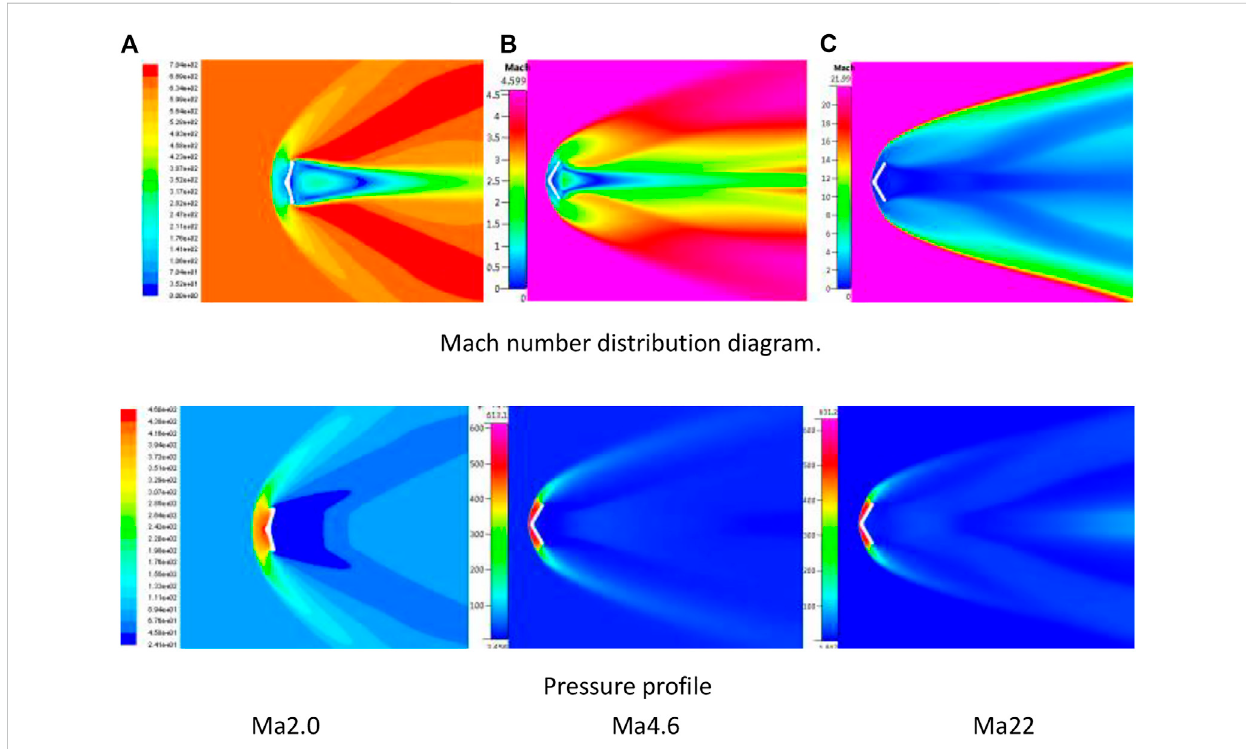
FIGURE 4 Velocity and pressure distribution of the symmetrical surface of the fl ow fi eld under different Mach conditions (upper: Mach number, lower: pressure).